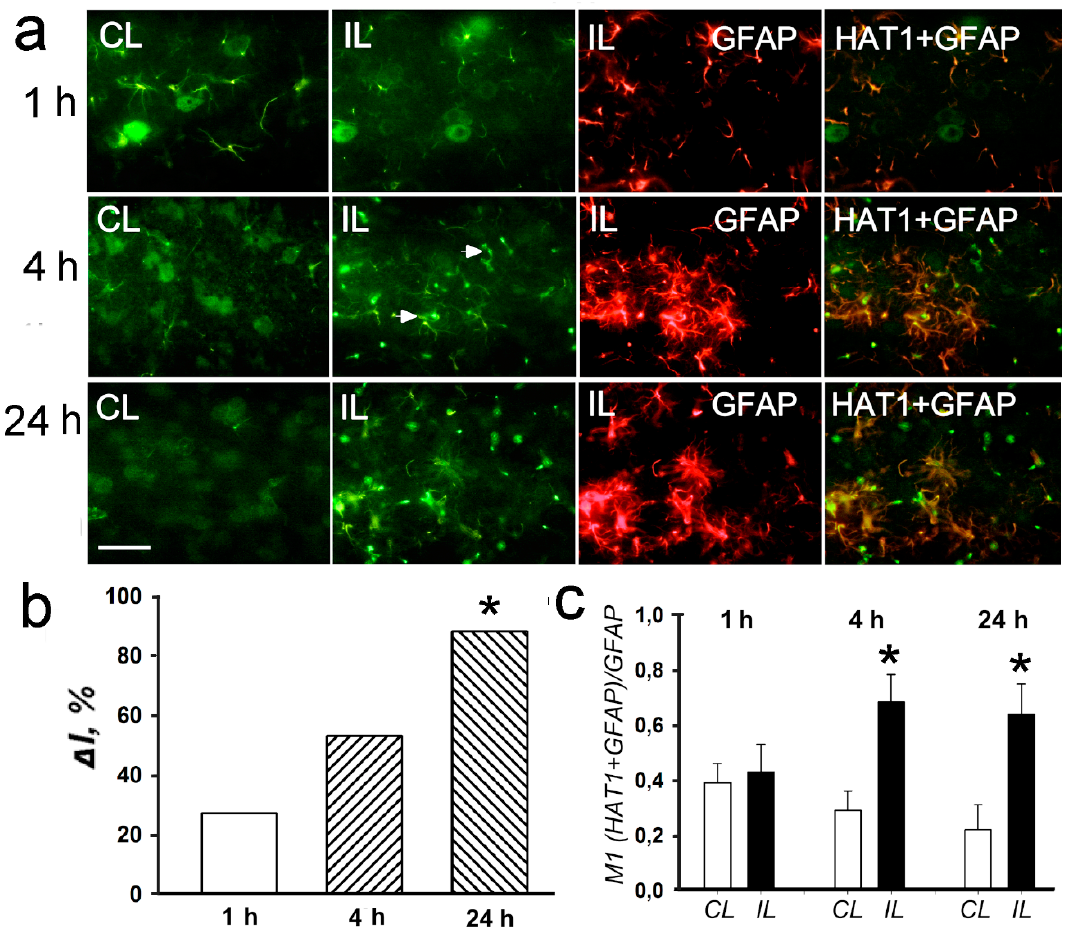
Figure 8. The cellular distribution and expression of histone deacetylase HAT1 in the penumbra at 1, 4 or 24 h after PTS in the rat cerebral cortex. ( a ) The typical immunofluorescence images of HAT1 expression (green) in the ischemic penumbra (IL) and in the control contralateral cortex (CL), the expression of astroglia marker GFAP (red) and merged images of HAT1 and GFAP. HDAC2 fluorescence in GFAP-labeled astrocytes is yellow. White arrows—HAT1 expression in astrocytes. Scale bar, 20 µ m. ( b ) Percent changes in fluorescence intensity of HAT1-positive cells in the ischemic penumbra 1, 4, or 24 h after photothrombotic stroke in the rat cerebral cortex relatively to that in the control contralateral cortex. ∆ I % is mean corrected total cell fluorescence (CTCF) averaged in the penumbra minus mean control CTCF / mean control CTCF × 100% (experiment versus control). ( c ) Manders’ coe ffi cients M1 that display the PTS-induced changes in co-localization of HAT1 with GFAP. n = 7. * p < 0.05.